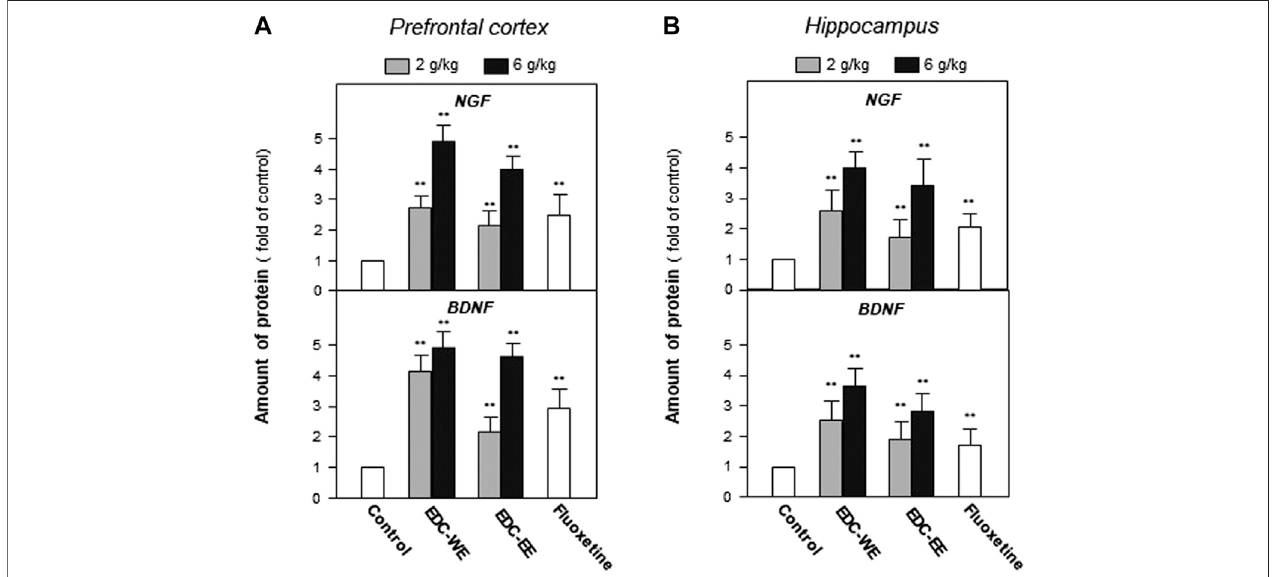
FIGURE2| ExtractsofElaphuriDavidianiCornu(EDC)increasedtheexpressionsofneurotrophicfactorsintheprefrontalcortexandhippocampustissuesofmice. (A) : Mice were given aqueous (EDC-WE) and ethanol extracts (EDC-EE) of EDC by intragastric administration at the stated doses — for 7 days. The amounts of nerve growth factor and brain-derived neurotrophic factor were determined in the tissues of the prefrontal cortex of the sacri fi ced mice. Fluoxetine was used as a positive control(4 mg/kg/day). (B) :Thesamples werethesameasin (A) and theamounts ofnervegrowth factor and brain-derived neurotrophicfactor were determined in the tissues of the hippocampus of the sacri fi ced mice. Values are expressed as the percentage of the control group (no drug treatment group), as mean ± SEM ( n (cid:1) 8). * p < 0.05, ** p < 0.01 (compared with the control group).